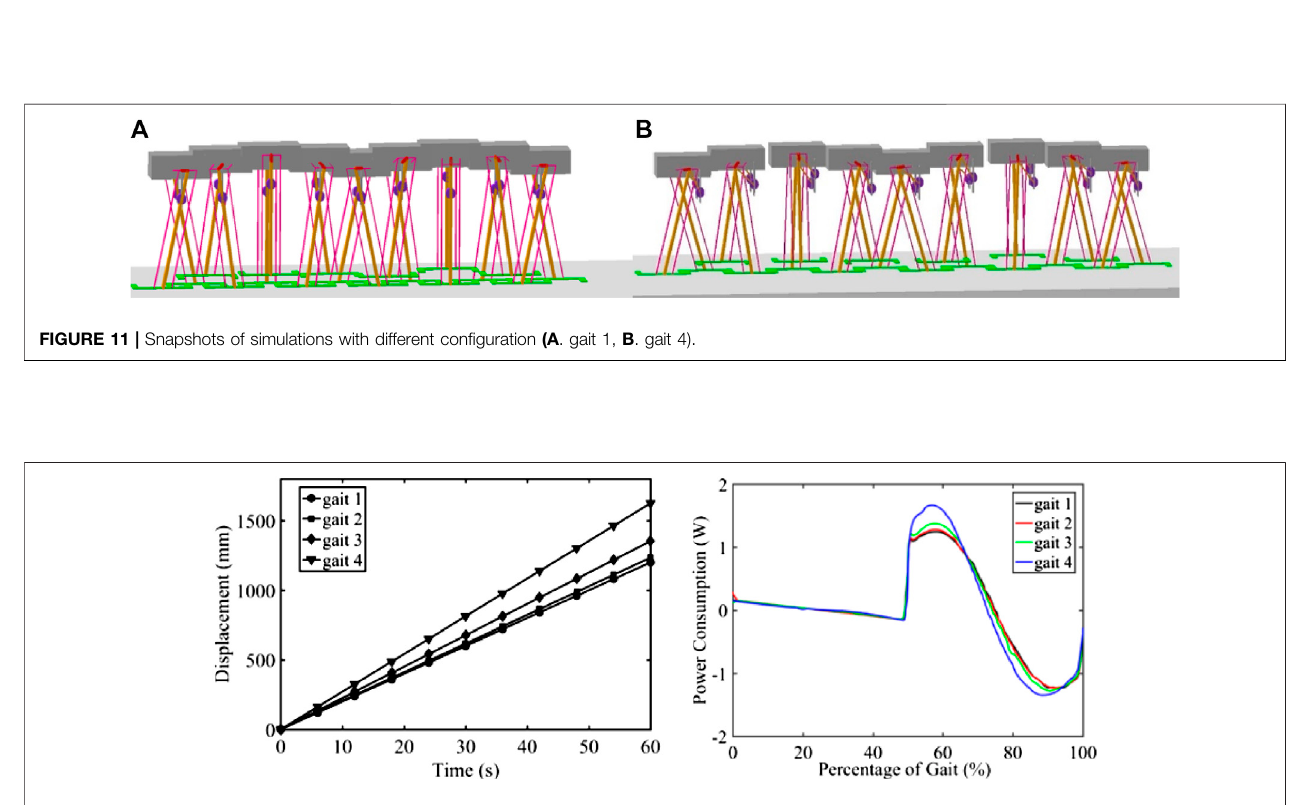
point was on B 1 and B 2 respectively. The same input motion speed was set for both of the simulations. Figure 13 shows the horizontal displacement and and power consumption of the actuator with the fi xed points on B 1 or B 2 . And the snapshots of the simulations are shown in Figures 14A,B . It can be seen that, with different fi xed positions, the walking robot can generate different gait with different